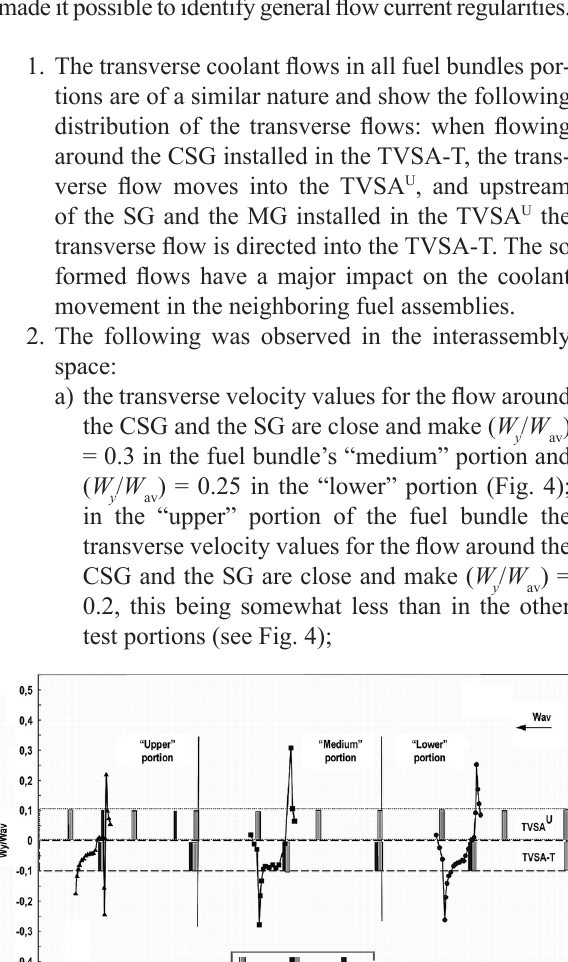
Figure 4. Distribution of the transverse velocity in the interas- sembly space ( W = 27.5 m/s, Re = 78000). av